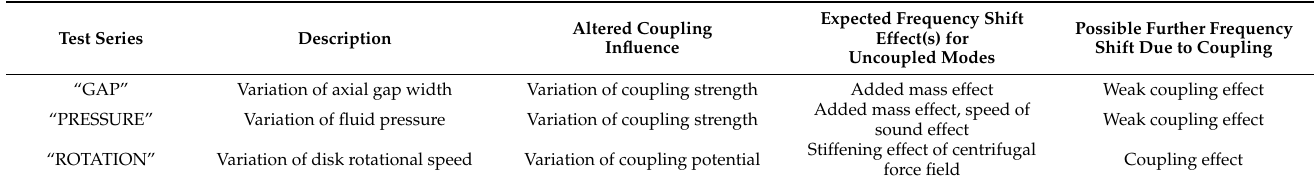
Table 1. Overview of conducted test series and expected frequency shift